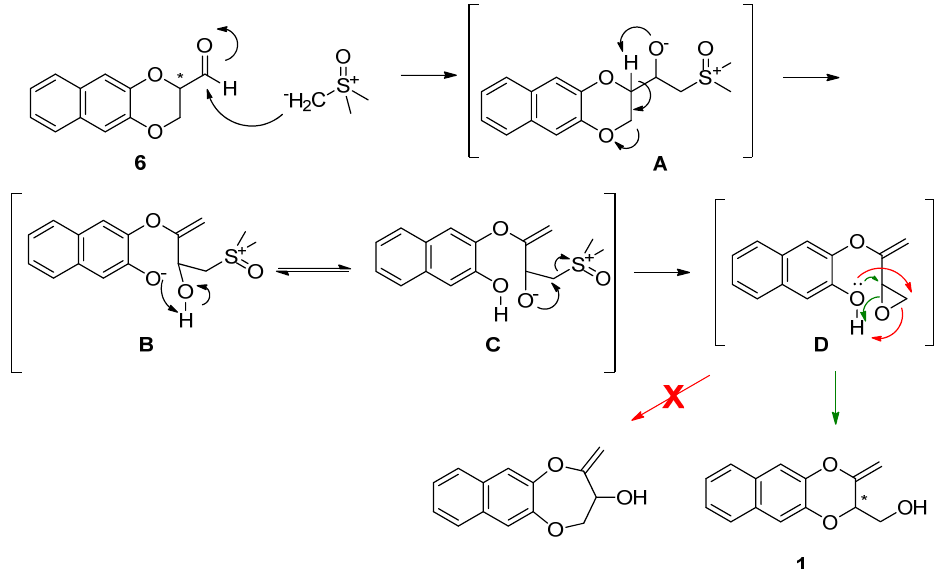
highlight the observed outcome of the reaction, achieving compound 1 , whereas red arrows indicate the obtainment of a second possible byproduct, which was not achieved in these